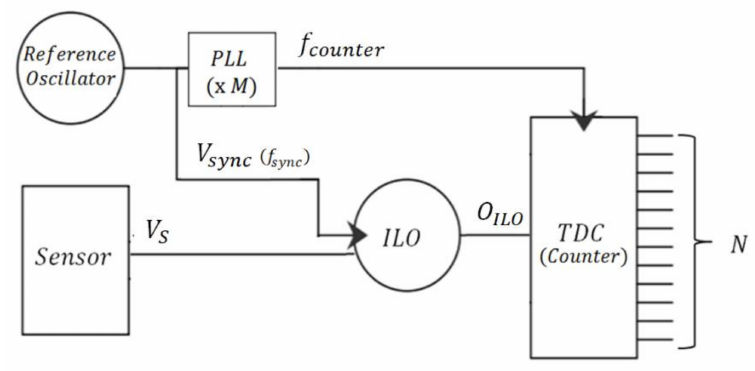
Figure 2. ILO-based Pulse Width Modulation (PWM) sensor interface.